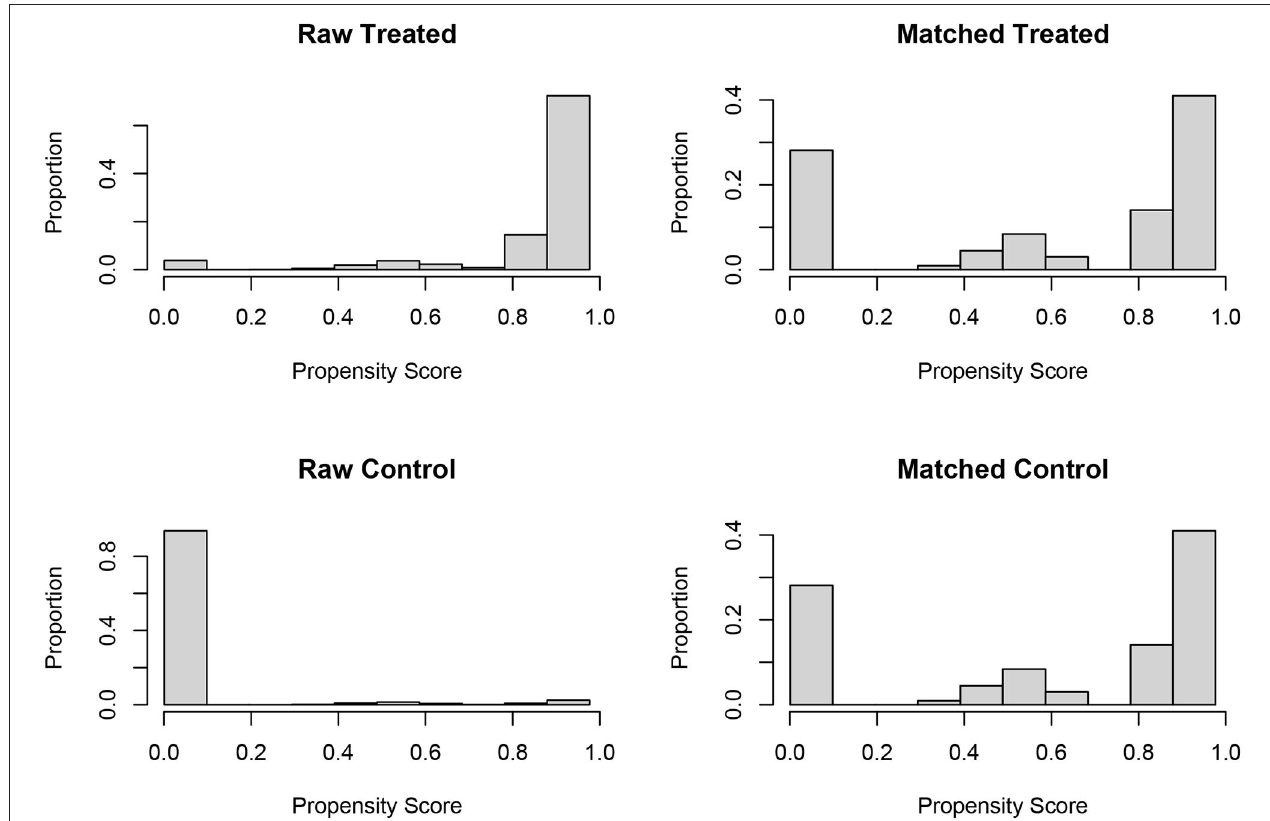
FIGURE 2 | Histograms of propensity score before and after the PS matching.